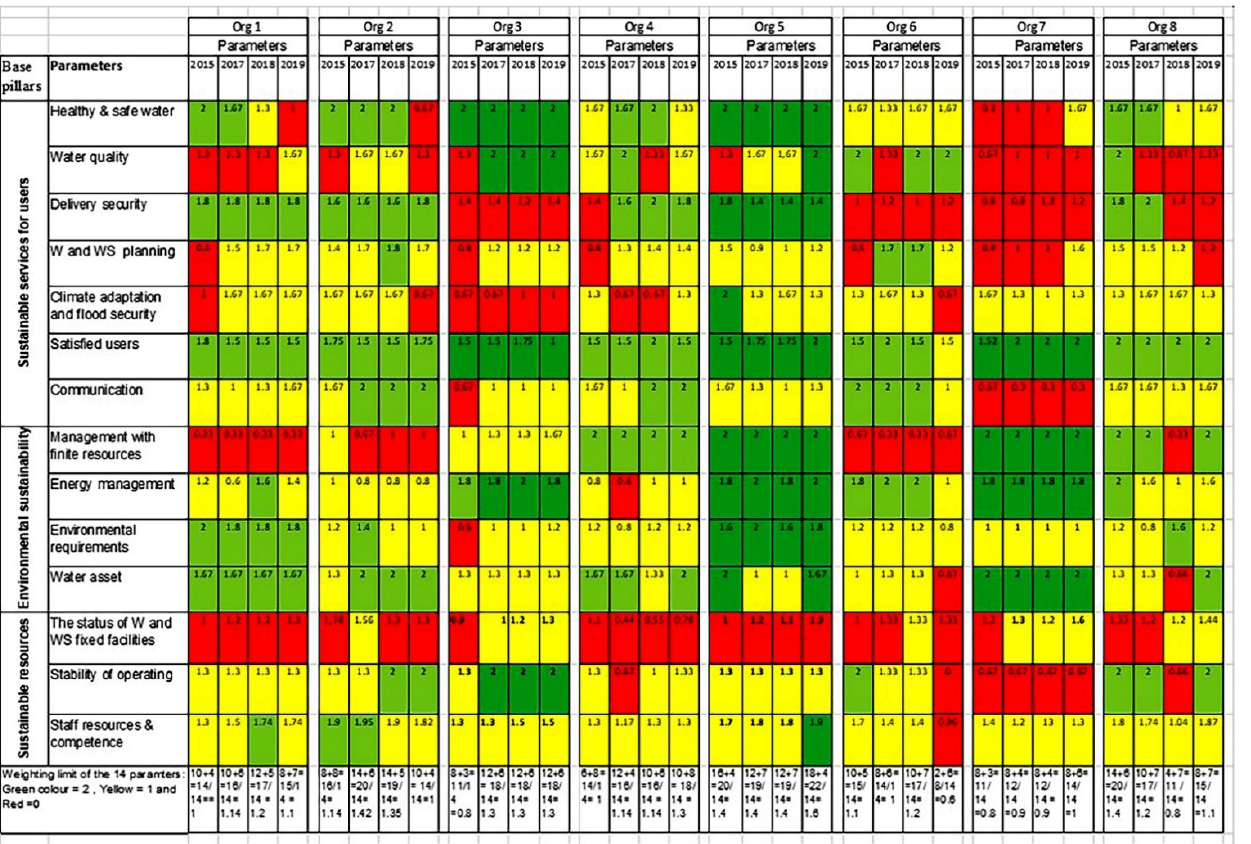
Water 2021 , 13 , x FOR PEER REVIEW 11 of 26 Figure 8. Compilation of results of SI parameters for Orgs 1–8 during 2015, 2017, 2018, and 2019.